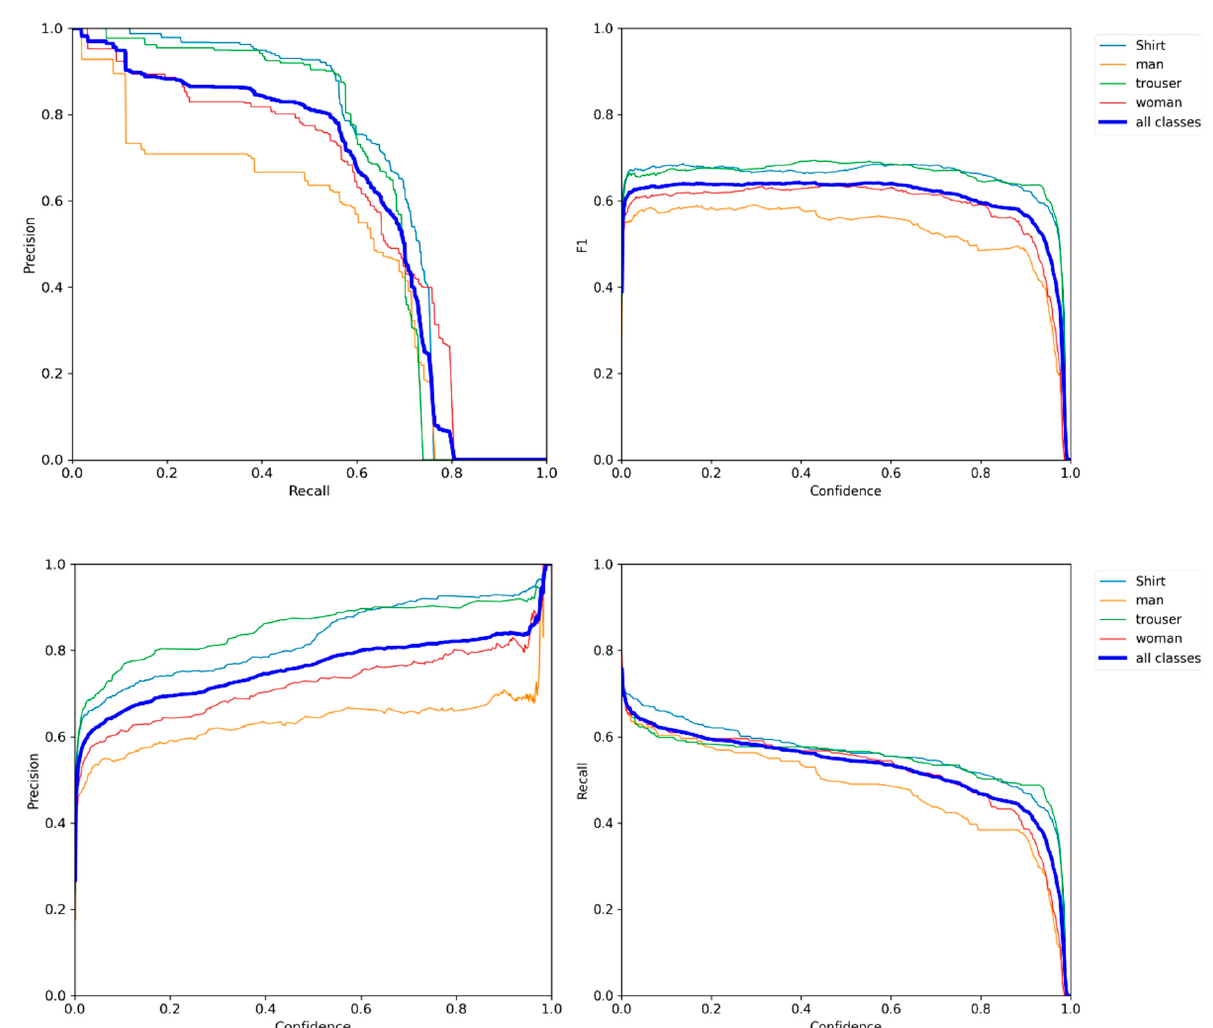
Figure 11. The performance metrics Precision, Recall, f1, and Precision-Recall of the four classes when the PGC dataset had been used to train YOLOv5. The YOLOv5 model was used to create these graphics.